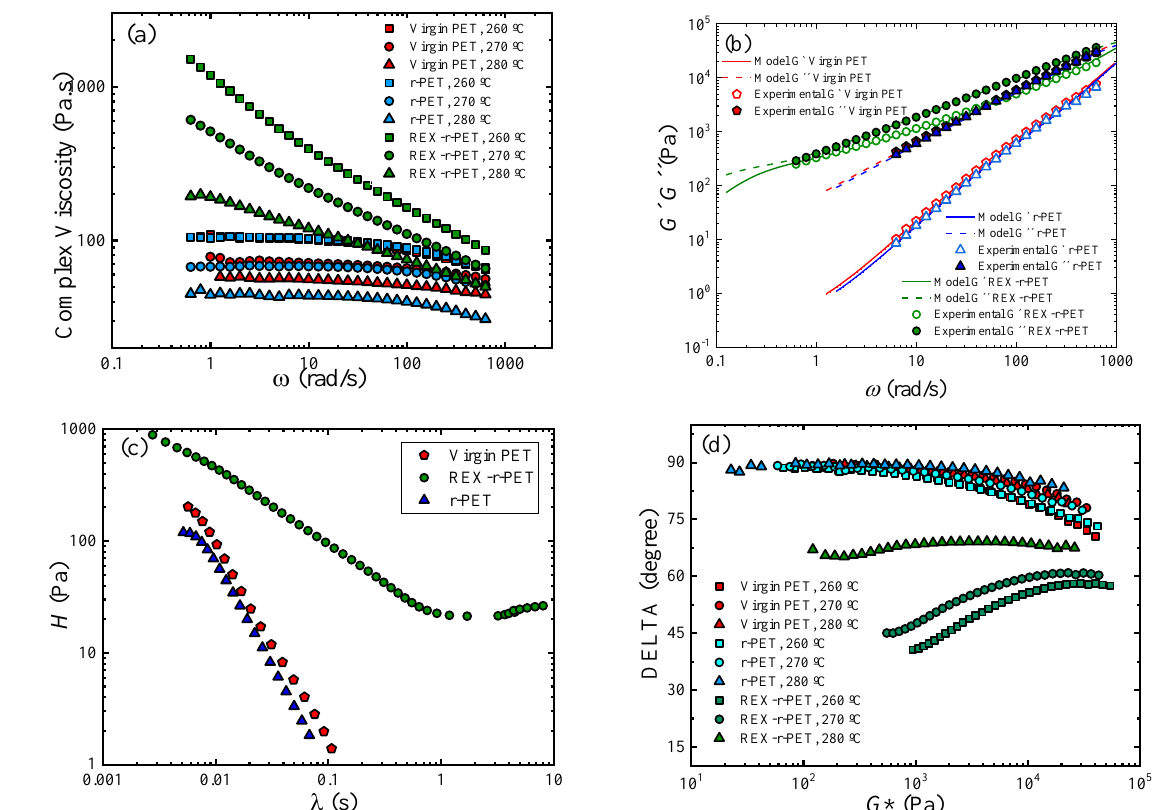
Figure 9. Linear viscoelastic data for virgin PET, r-PET, and REX-r-PET. ( a ) Complex viscosity at three temperatures: T = 260 ◦ C, T = 270 ◦ C, and T = 280 ◦ C. ( b ) Moduli data obtained at T = 270 ◦ C fitted to the Maxwell model. ( c ) Relaxation time spectra for virgin PET and REX-r-PET, and ( d ) van Gurp Palmen plot at temperatures T = 260, 270, and 280 ◦ C for virgin PET, r-PET, and REX-r-PET.